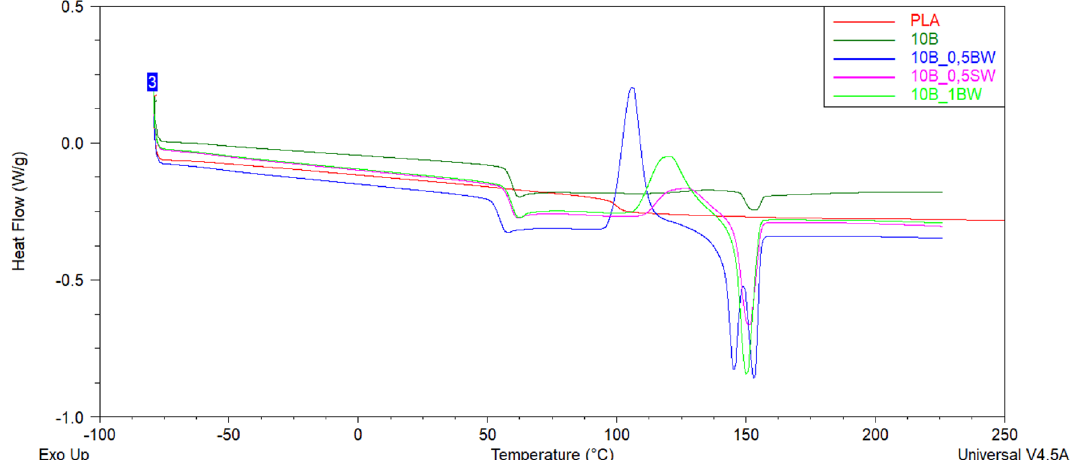
Figure 10. DSC curves of unmodified PLA and 10% DE composites with different type and loading of waxes obtained during second heating cycle.